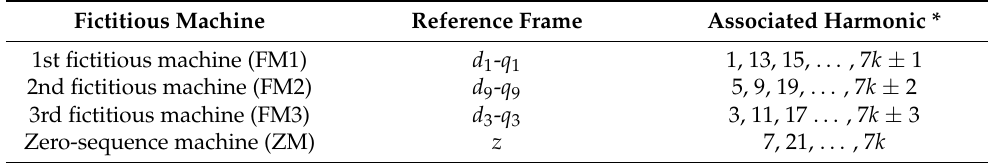
Table 1. Fictitious machines, reference frames, and associated harmonics in natural frame of a seven-phase machine (only odd harmonics are considered). Fictitious Machine Reference Frame Associated Harmonic